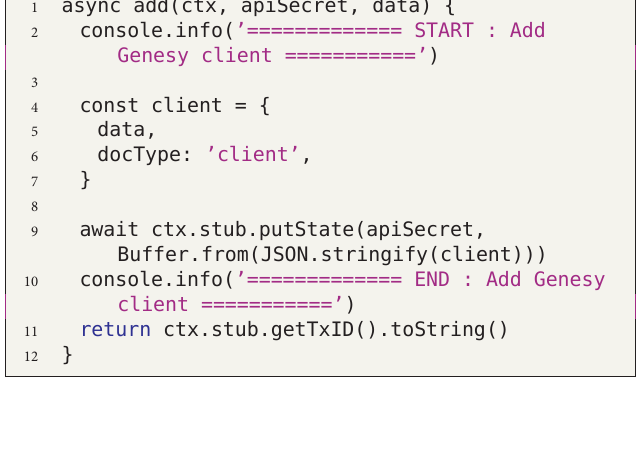
TABLE A1 | Definizione dell’API di scrittura all’interno del server